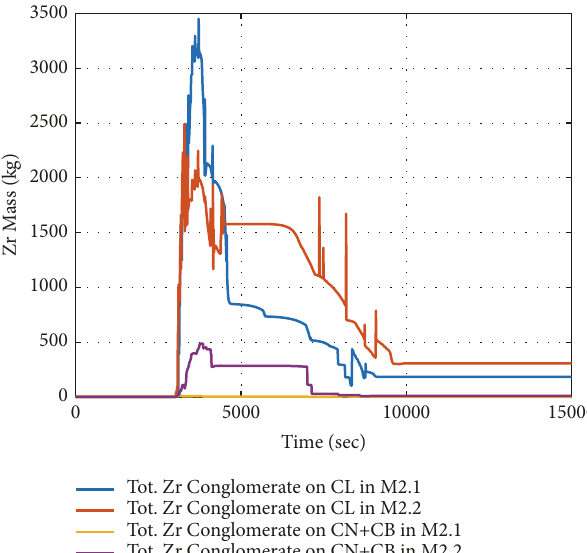
Figure 15: Total mass of Zr conglomerate on cladding (CL) and canister (CN+CB) in MELCOR 2.1 and MELCOR